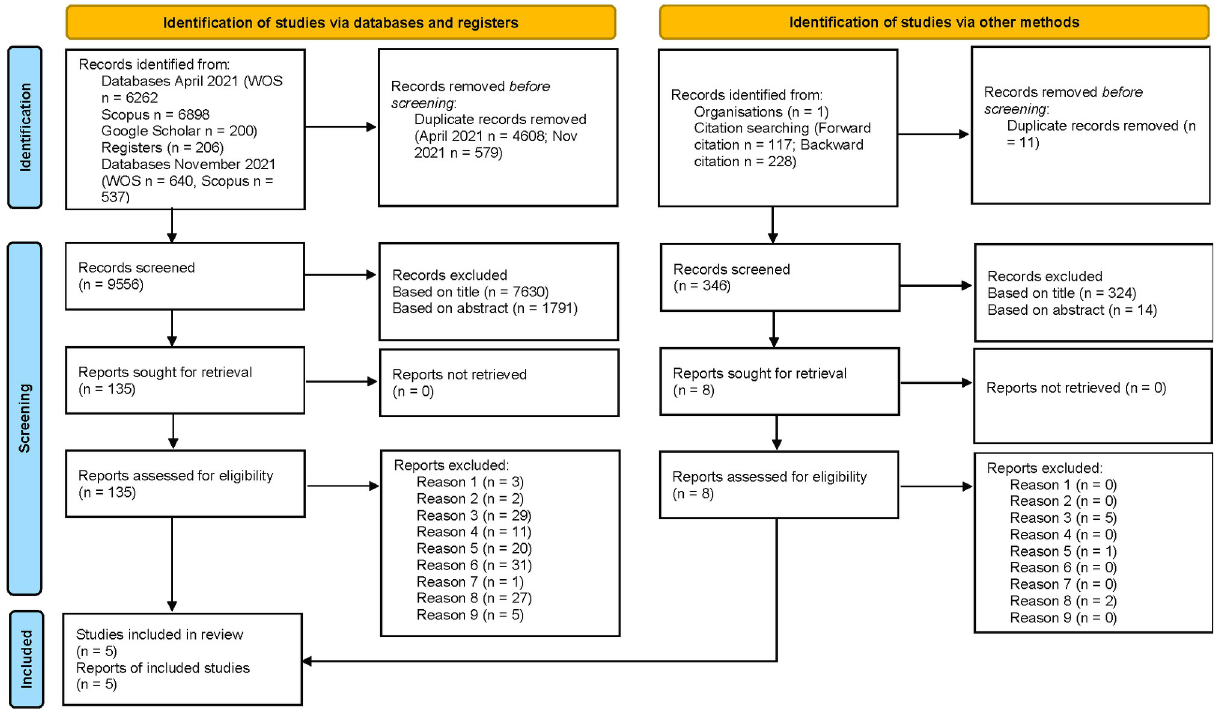
Fig 1. Prisma flow